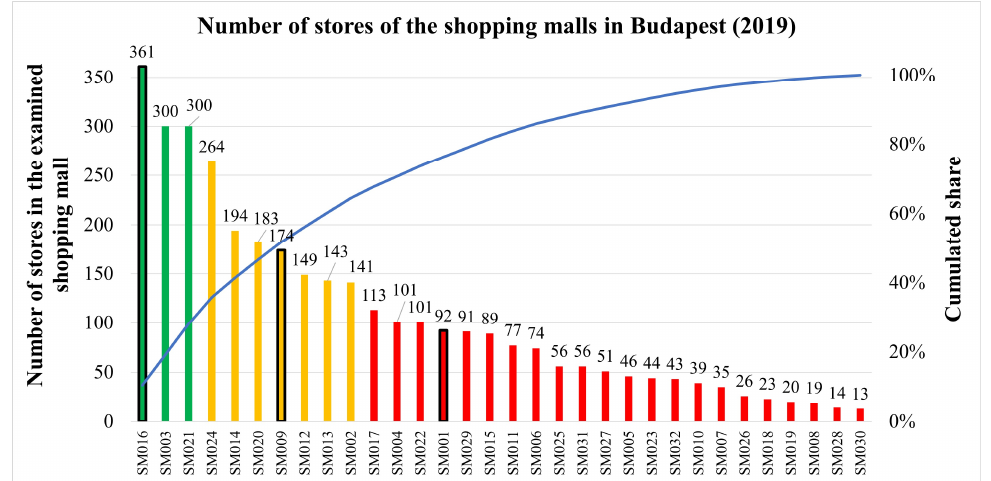
Figure 6. The number of stores and the ABC category of the examined shopping malls.